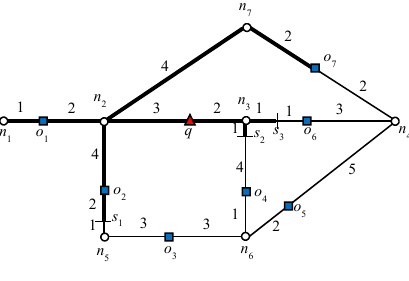
Figure 3. Influence region of o 1 .